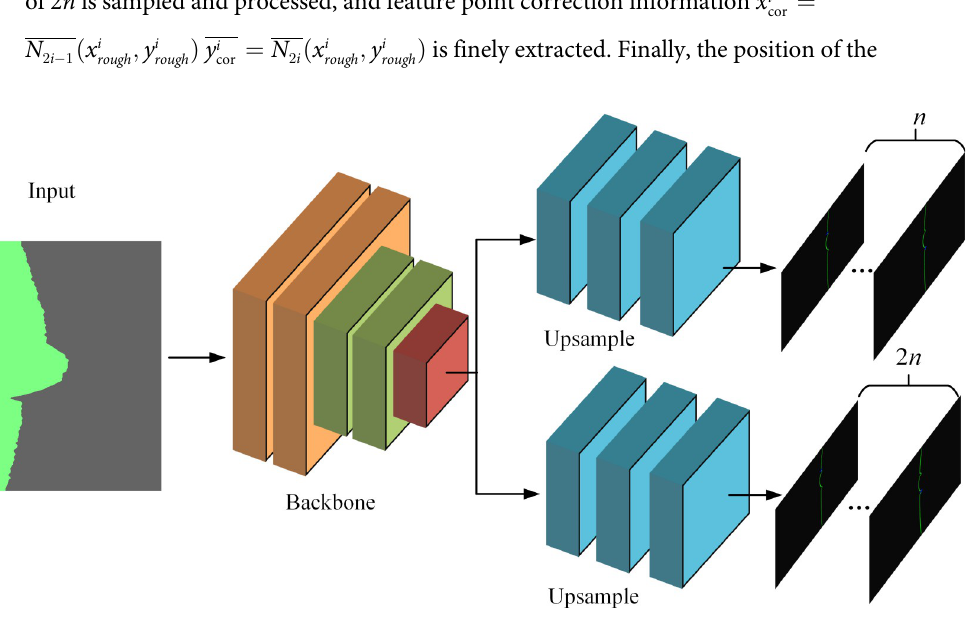
Fig 5. Network structure diagram of